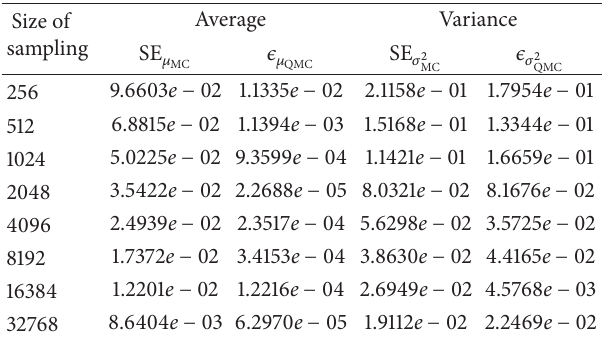
Table 20: Error of the average and variance MC, QMC approxima- tions of CIR interest rate model at time 𝑇 = 1 for 𝛼 = 0.1 , 𝛽 = 0.002 , = 110 𝜎 = 15 %, and 𝑅 0